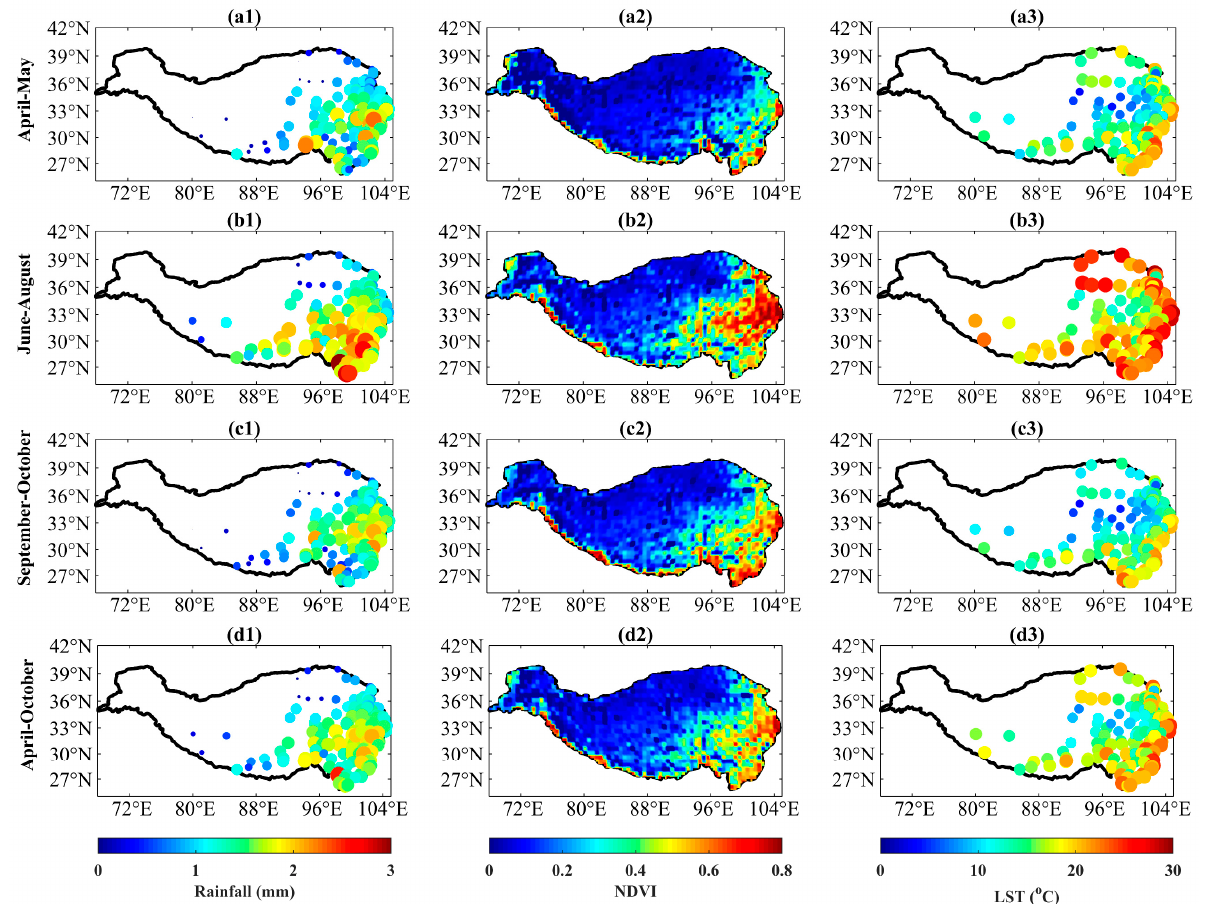
Figure 10. Spatial distributions of daily rainfall, NDVI, and LST in different seasons during the non-frozen period from 2015 to 2016 in the TP. The size of the circles represents the absolute values of rainfall ( a1 – d1 ), NDVI ( a2 – d2 ), and LST ( a3 – d3 ) at each observation site.